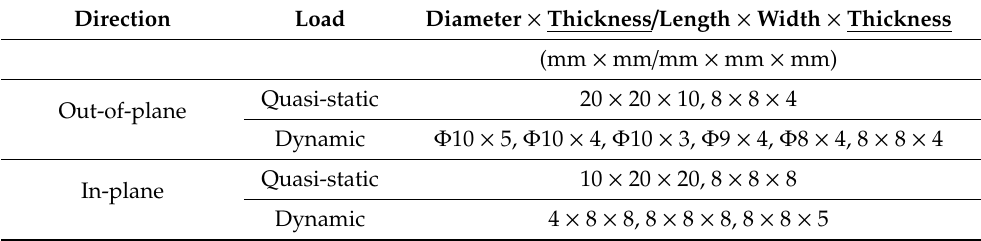
Table 1. The sizes of the